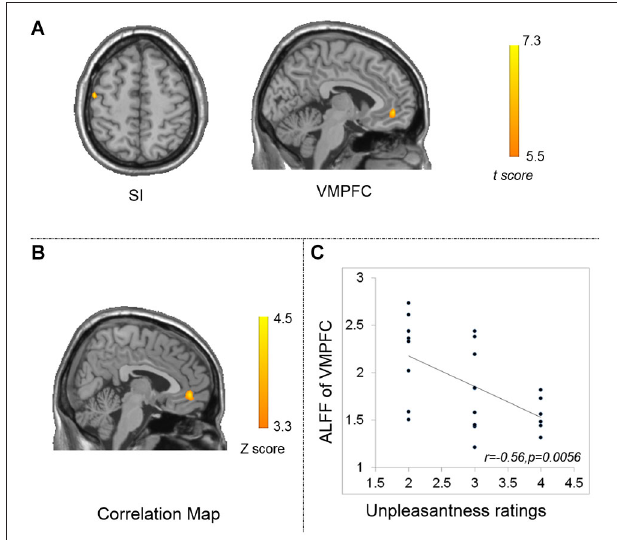
FIGURE 2 | Results of ALFF differences between groups (p < 0.05, FWE corrected) (A) and correlation maps between ALFF and unpleasantness ratings for the acupuncturist group (B,C) . (A) the acupuncturist group showed larger ALFF in the left VMPFC (displayed in sagittal view) and the left SI (displayed in axial view). (B) Significant correlation between ALFF and unpleasantness ratings was found in the left VMPFC. The statistical threshold was set at |Z| > 3.29 ( p < 0.001 at the individual voxel level) and cluster size > 45 voxels, which corresponds to a corrected p < 0.05. (C) scatter plot map computed as ALFF of the peak voxel in the correlation analysis and unpleasantness ratings. VMPFC: the ventral medial prefrontal cortex; SI: the primary somatosensory